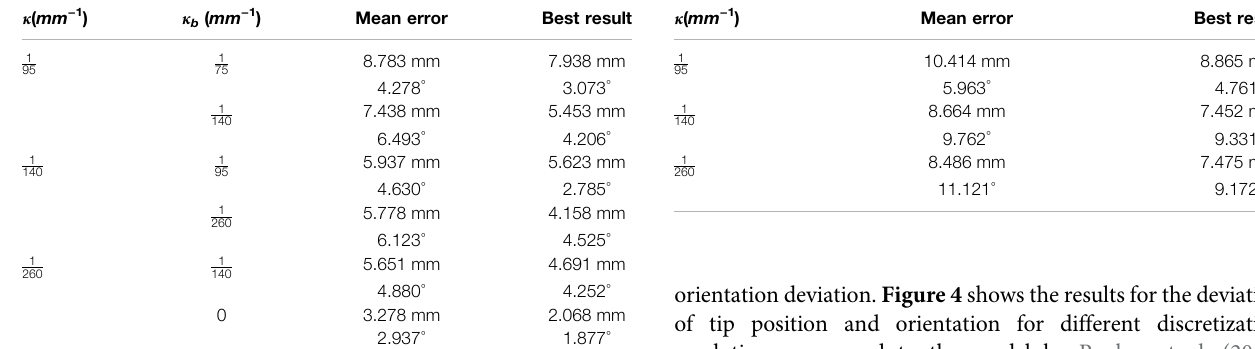
TABLE 4 | Results of torsional